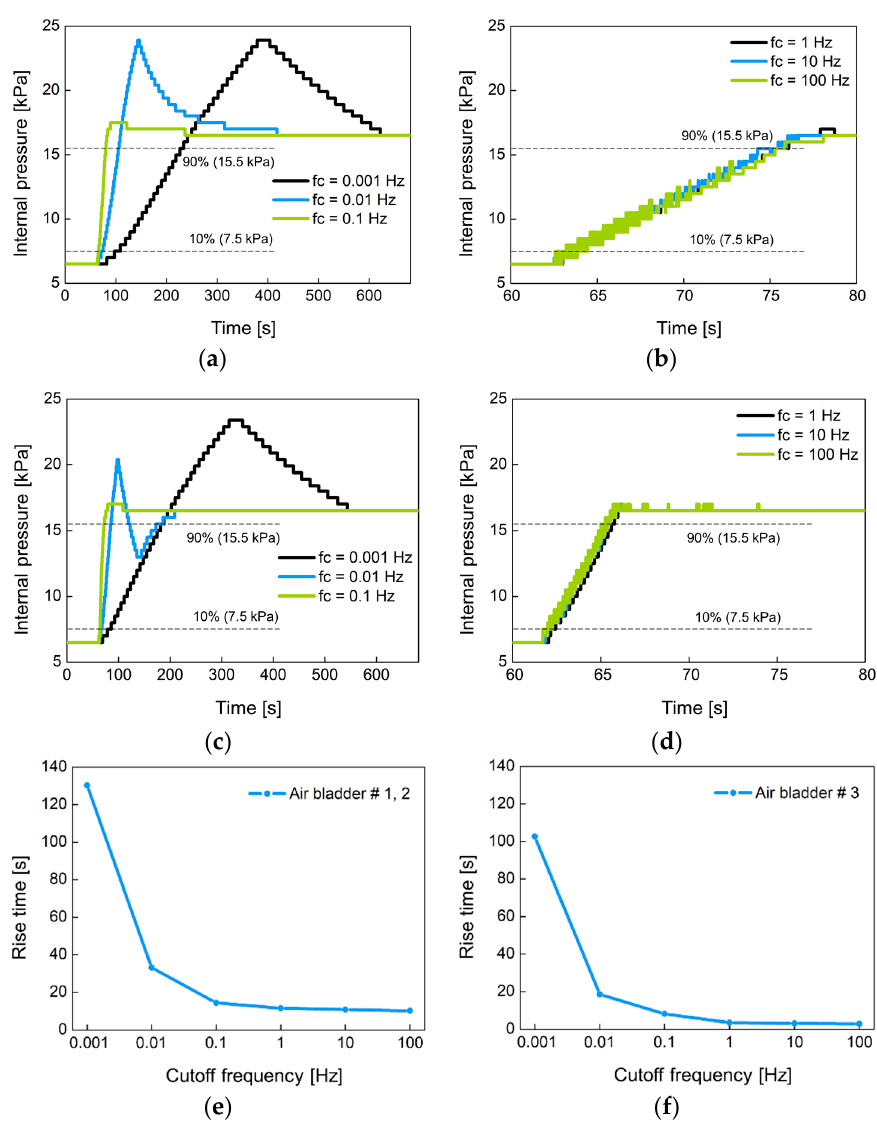
Figure 14. The change of the internal pressure when the set point pressure was changed from 6.5 kPa to 16.5 kPa in 10 kPa step at ( a ) low and ( b ) high cutoff frequencies for large air bladder #1 (or #2); ( c ) low and ( d ) high cutoff frequencies for small air bladder #3; the rise time in terms of cutoff frequency for ( e ) large air bladder #1(or #2) and ( f ) small air bladder #3. Figure 15 shows the operation of the 3-way pneumatic valve with hysteresis control. V lower , the valve control signals of V sol1 and V sol2 (red and green line) of active low are generated to move the solenoid plunger. When the pressure signal is greater than V upper , the right coil of the solenoid is activated, and the plunger moves to the left. During this period, the air in the bladder is released into the atmosphere and the air pump does not work. When the pressure signal is below V upper , the left solenoid coil is activated and then the plunger moves to the right. Here, when the pressure signal is between the V upper